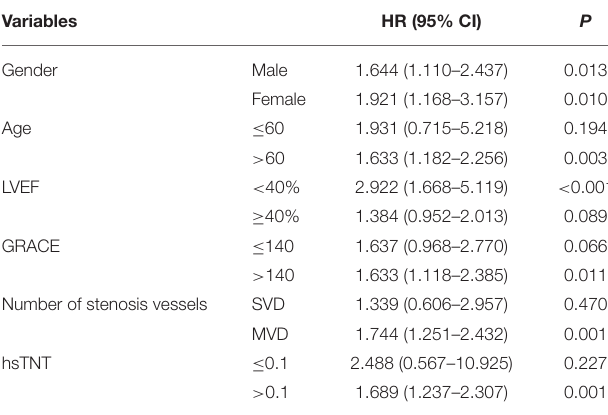
TABLE 4 | Multivariate COX regression analysis of each